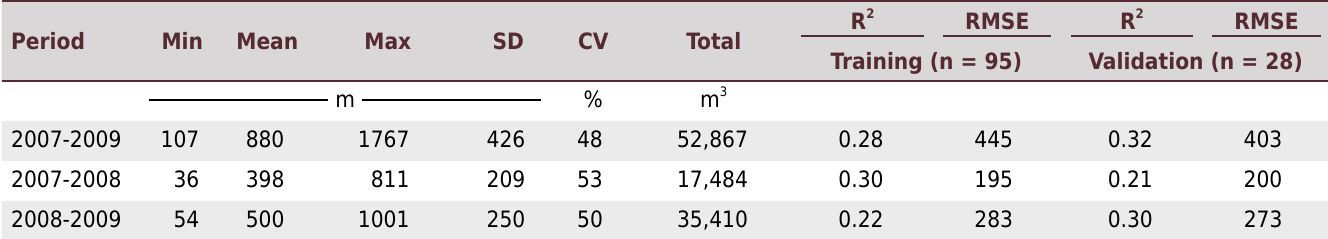
Min = minimum; Max = maximum; SD = standard deviation; CV = coefficient of variation; R 2 = R-squared; RMSE = root mean squared